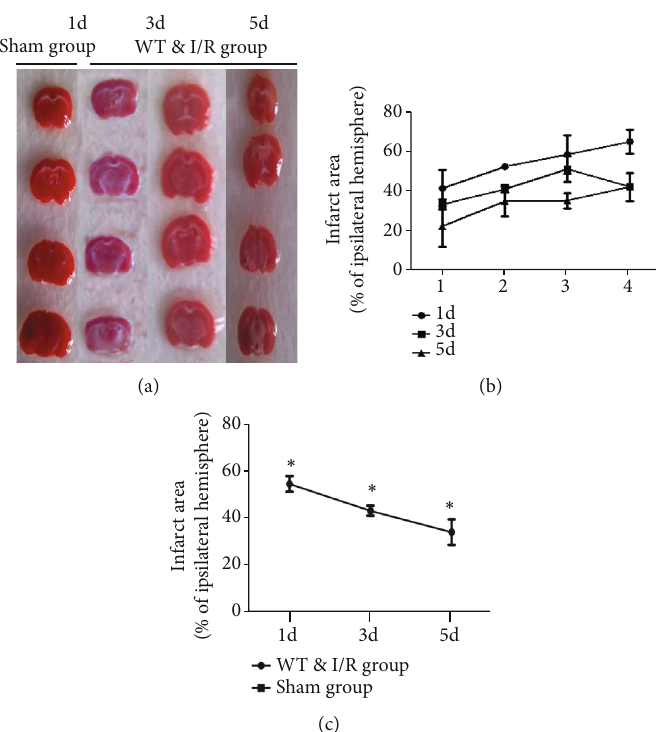
Figure 3: TTC staining was performed at 1 d, 3d, and 5d after cerebral ischemia/reperfusion. (a) TTC staining sections graph at 1 d, 3d, and 5 d cerebral ischemia/reperfusion compared with the sham group. The white color indicates the infarct area. (b) The bar graph is a representation of the quantitative infarct area with TTC staining at 1d, 3d, and 5d. (c) The bar graph represents quantitative infarct volume from the TTC staining at 1 d, 3 d, and 5d cerebral ischemia-reperfusion, compared with the sham group, n = 3 per group, ∗ p < 0 : 05 , sham vs. I/R group. ∗ p < 0 : 05 by one-way